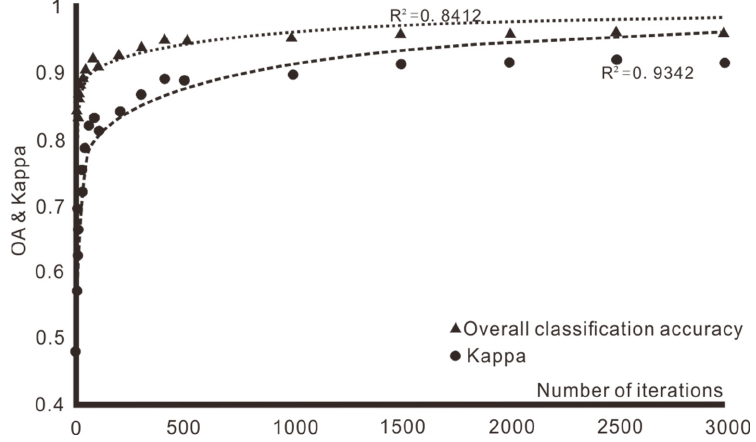
Figure 16. The number of iterations and the relationship between the OA and Kappa